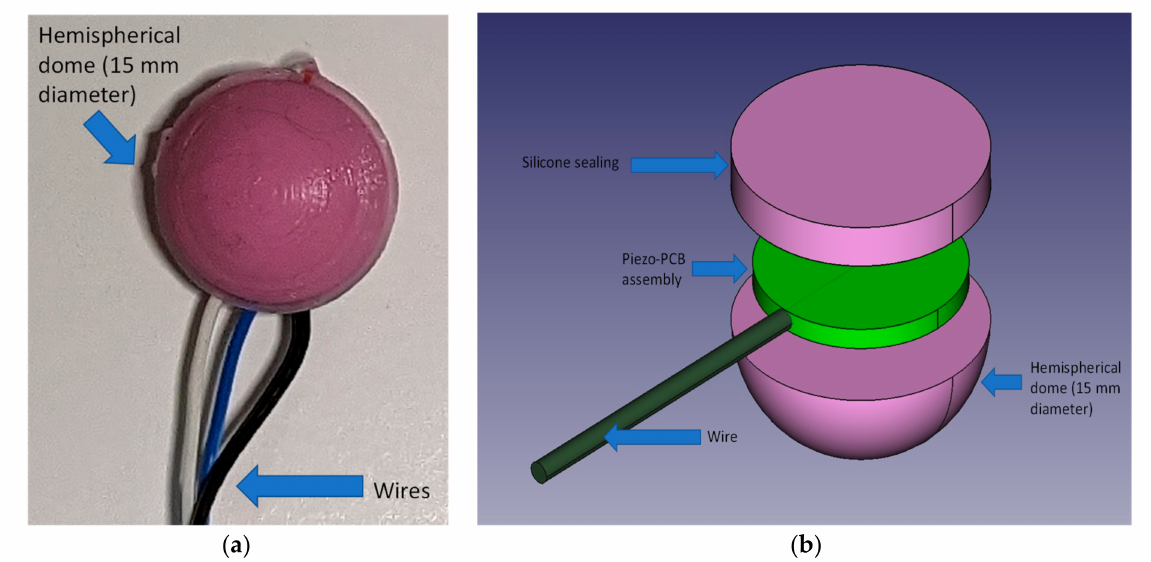
Figure 1. Domed Silicone Enclosure; ( a ): picture of the actual assembly; ( b ): assembly exploded view (not to